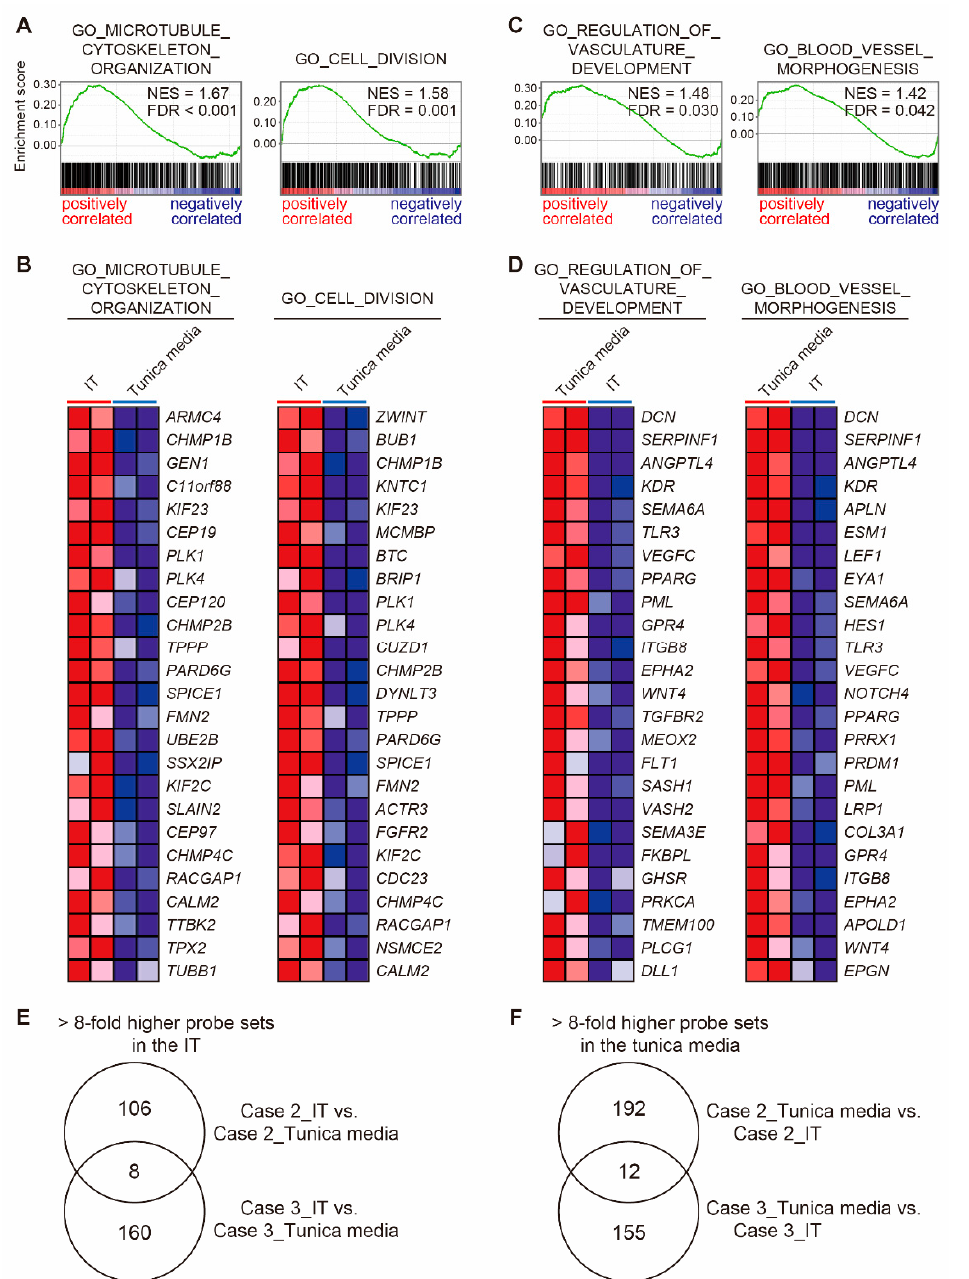
Figure 6. Differential gene expression between the intimal thickening (IT) and the tunica media of the closing human ductus arteriosus (DA) tissues. ( A ) Gene set enrichment analyses (GSEAs) revealed positive correlations between the IT of closing DA tissues and migration- and proliferation–related genes. ( B ) The top 25 genes that comprise the leading edge of the enrichment score in ( A ) are shown as a heatmap. ( C ) GSEAs revealed positive correlations between the tunica media of the closing DA tissues and vascular morphogenesis-related genes. ( D ) The top 25 genes that comprise the leading edge of the enrichment score in ( B ) are shown as a heatmap. ( E ) A Venn diagram shows the number of probe sets that were highly expressed (>8-fold) in the IT compared to the tunica media of closing DA tissues (Cases 2 and 3). ( F ) A Venn diagram shows the numbers of probe sets that were highly expressed (>8-fold) in the tunica media compared to the IT of closing DA tissues (Cases 2 and 3). NES, normalized enrichment score; FDR, false discovery rate. Figure 6E presents a Venn diagram that shows probe sets that were upregulated (>8- fold) in the IT of closing DA tissues compared to the tunica media of the same DA tissues